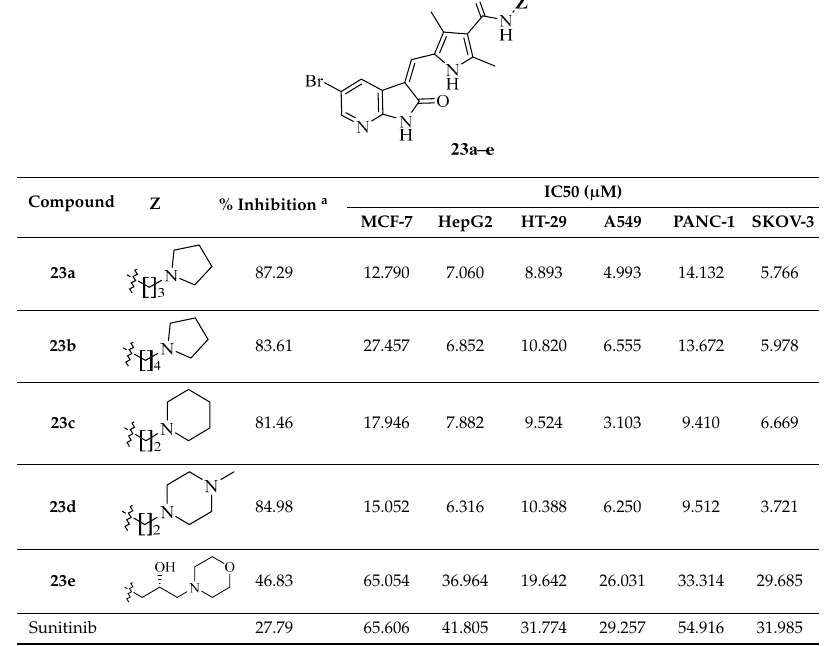
Table 1. In vitro activity of target compounds 23a – e against six cell lines.